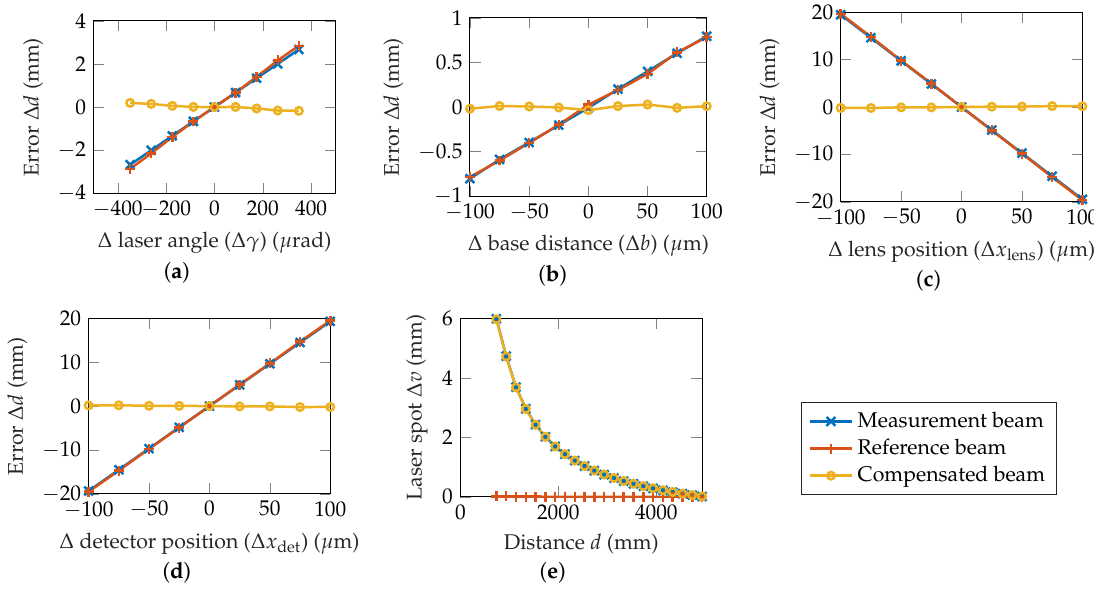
Figure 3. Simulated distance errors ∆ d of the measurement beam, the reference beam as well as the compensated beam ( ∆ d meas − ∆ d ref ) in dependence of a deviation of ( a ) the laser beam angle, ( b ) base distance ∆ b , ( c ) lens position ∆ x , ( d ) detector position ∆ x , and ( e ) measurement distance d